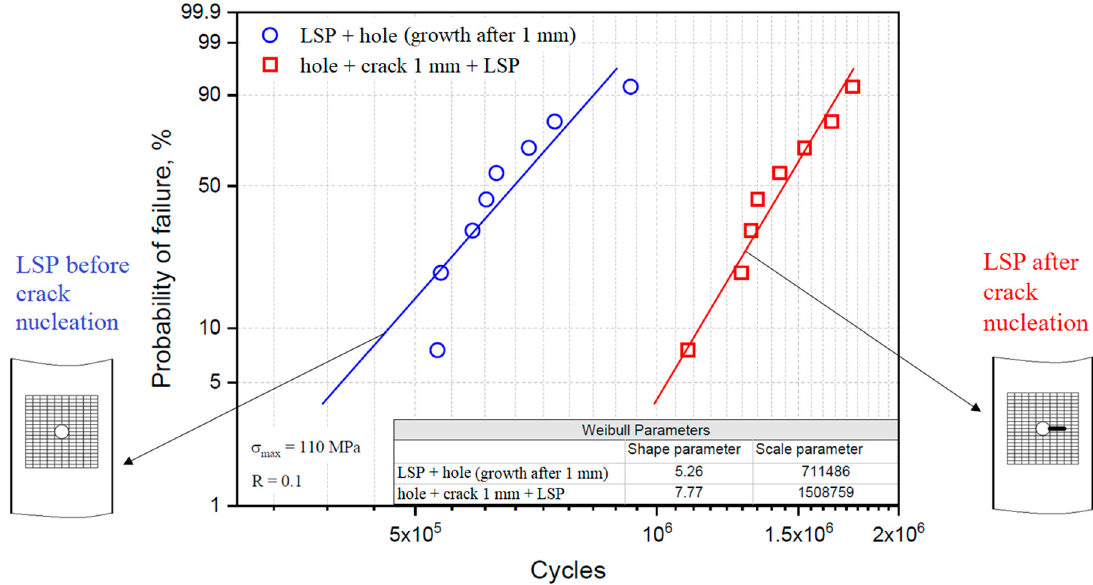
Figure 11. E ff ect of LSP sequence on the crack growth behavior after 1 mm crack Figure 11. Effect of LSP sequence on the crack growth behavior after 1 mm crack length.